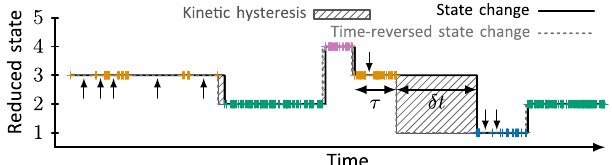
FIG. 6. Kinetic hysteresis. The coarse graining does not commute with time reversal. Transitions are “ odd ” under time reversal, while dwell periods are “ even, ” i.e., dwell periods commute with time reversal. The state change is the same as in Fig.